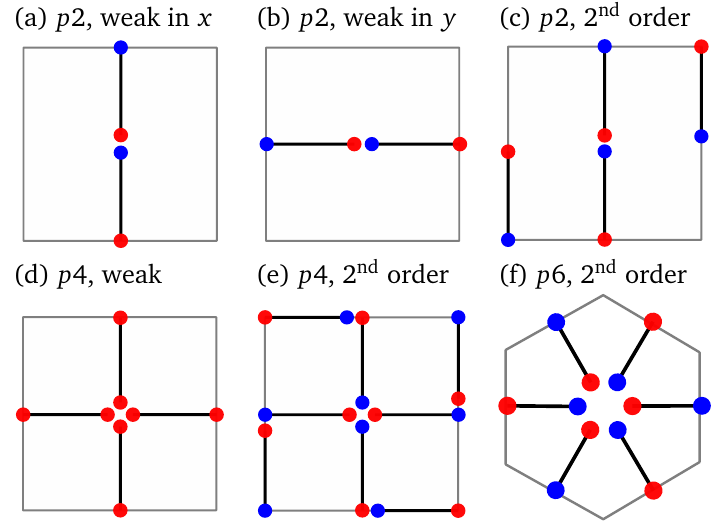
Figure 6: Generating sets of valid 1-cell decorations (cross sections of 2-cell decora- tions parallel to the rotation axis) of two (three) dimensional lattices with twofold, fourfold, and sixfold rotation axes. Black lines denote one (two) dimensional topo- logical phases with anomalous boundary states depicted as dots: for (cid:90) topological phases, the red and blue dots distinguish between topological charges q = + 1 and q = − 1, respectively. For (cid:90) topological phases with topological charges q mod 2, 2 the two colors are